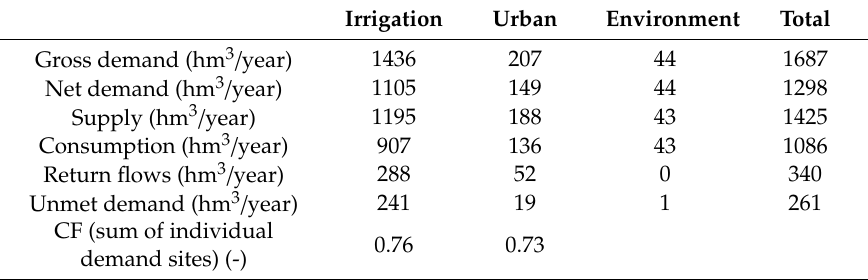
Table 2. Annual average supply and demand of di ff erent types of water users aggregated for the entire Segura Basin using the WEAP analysis (CF = Consumed